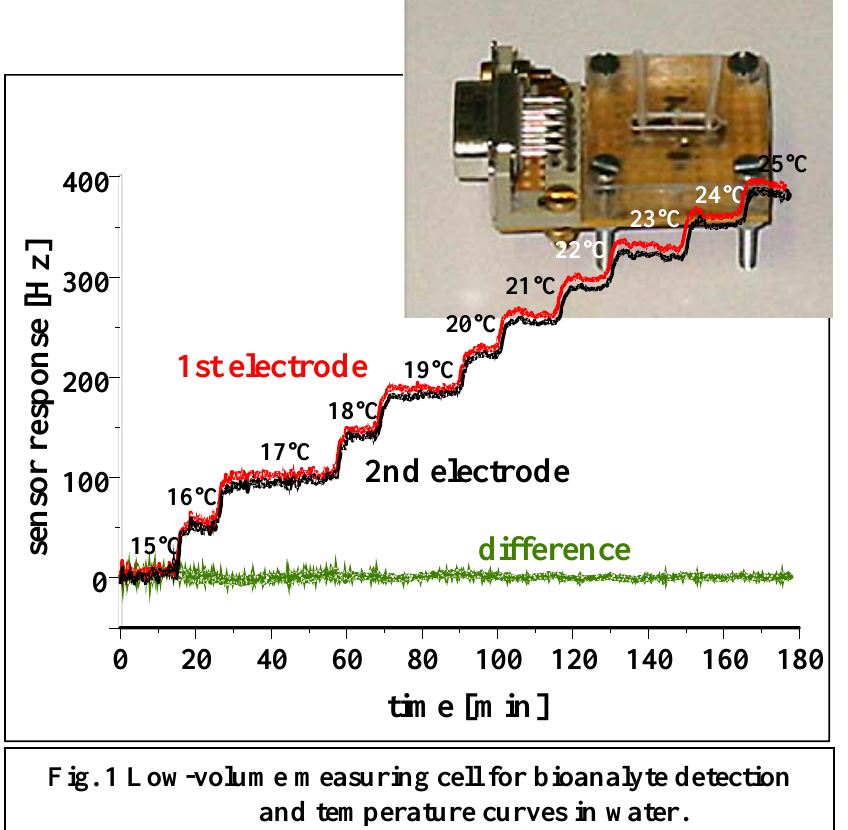
Fig. 1 Low-volume measuring cell for bioanalyte detection and temperature curves in